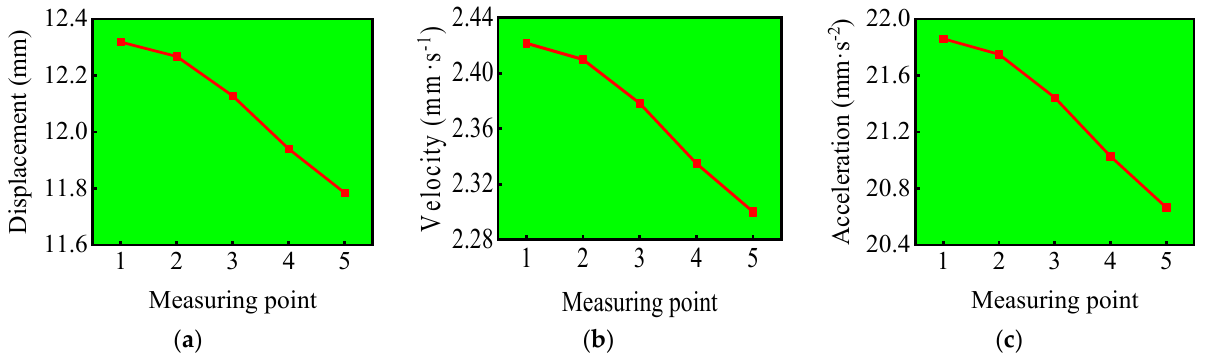
Figure 14. Peak value variation rule of measuring points under typical working condition ( a ) dis- placement, ( b ) velocity, and ( c ) acceleration.